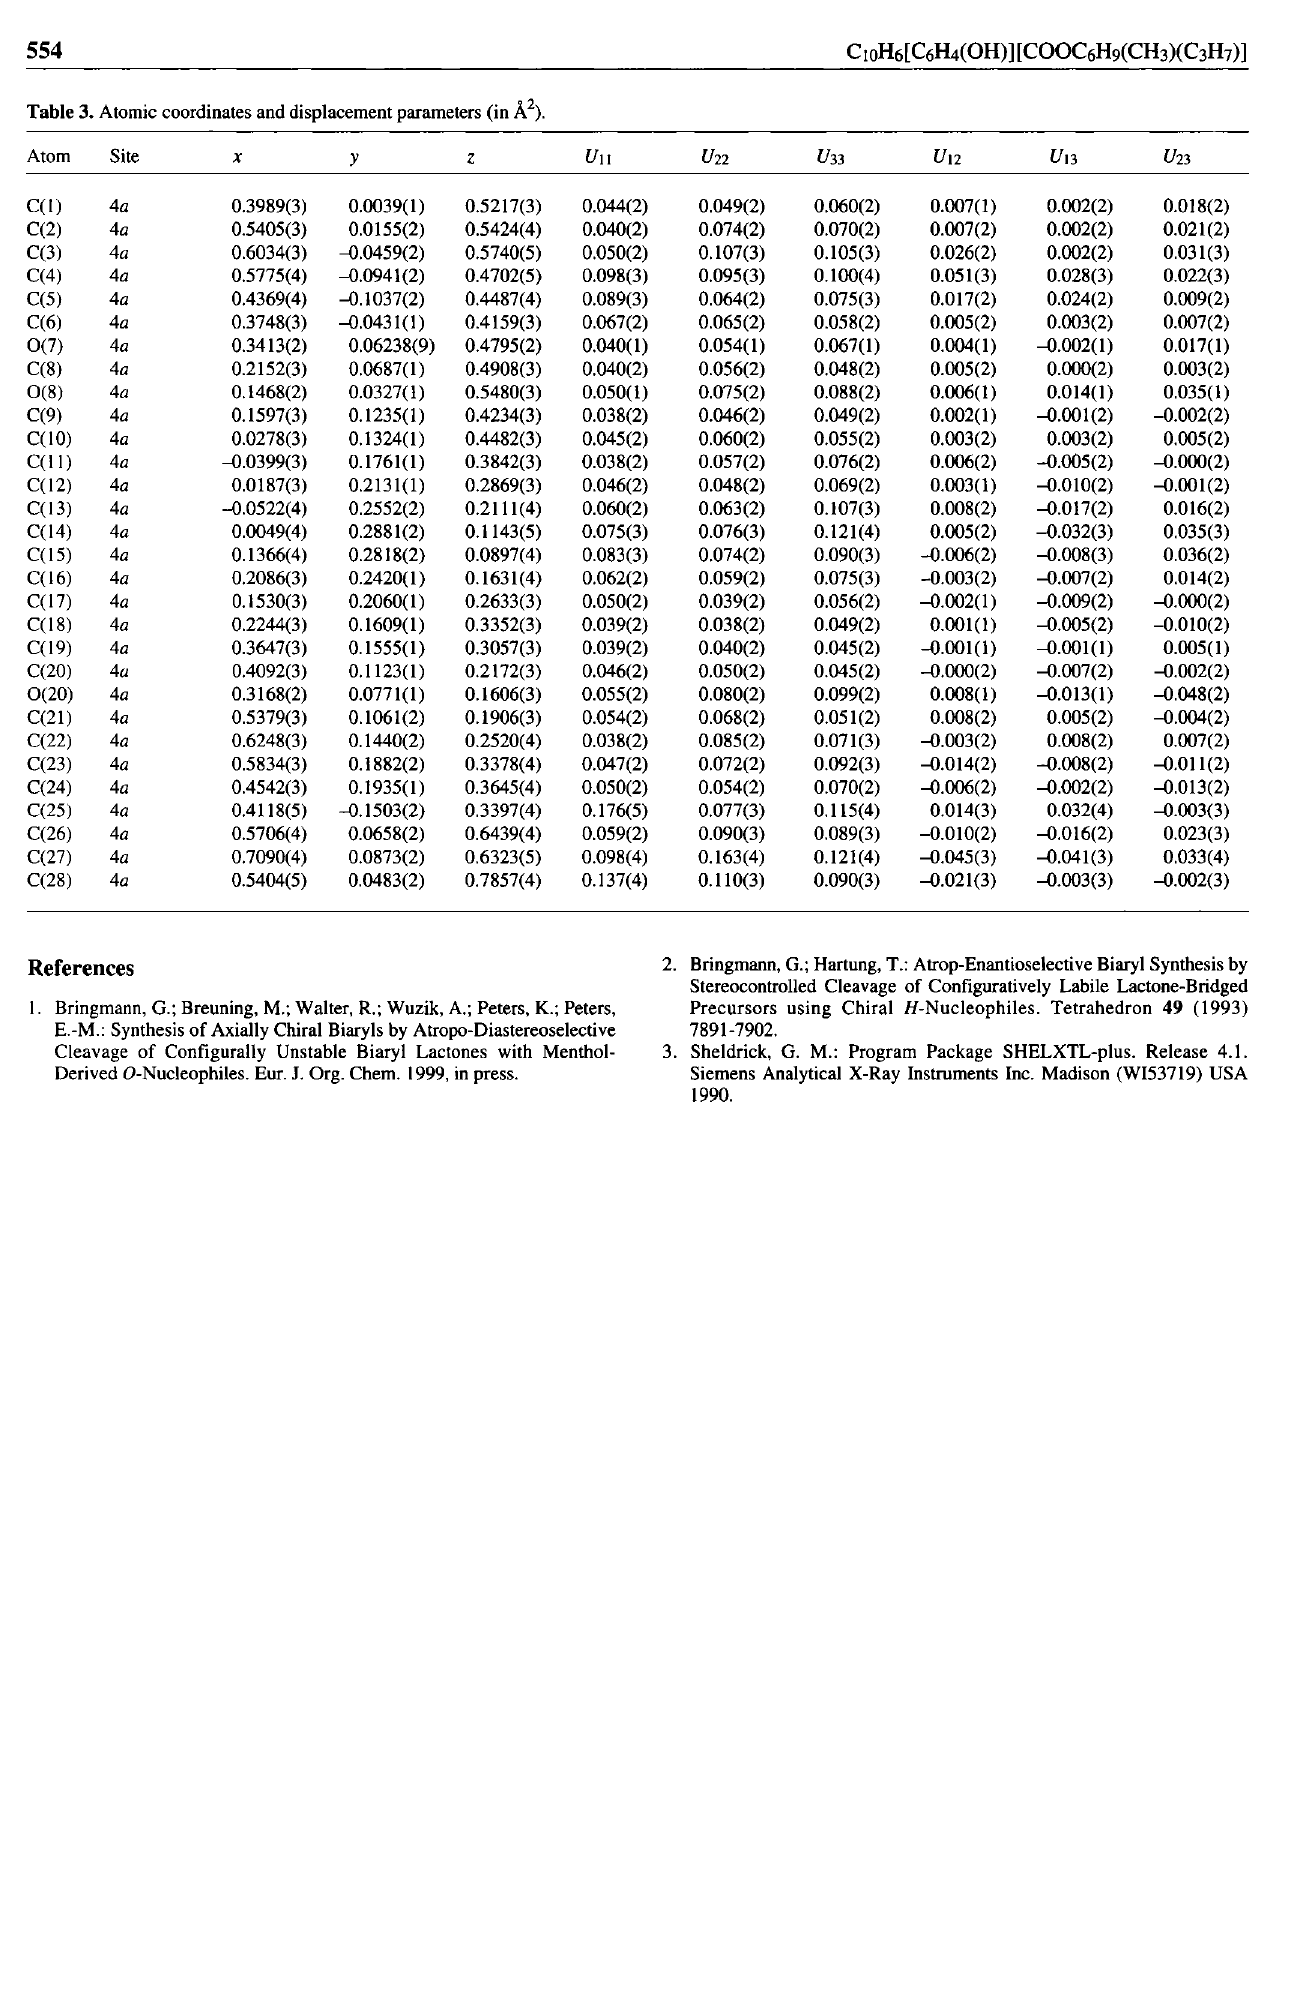
Table 3. Atomic coordinates and displacement parameters (in Ä 2